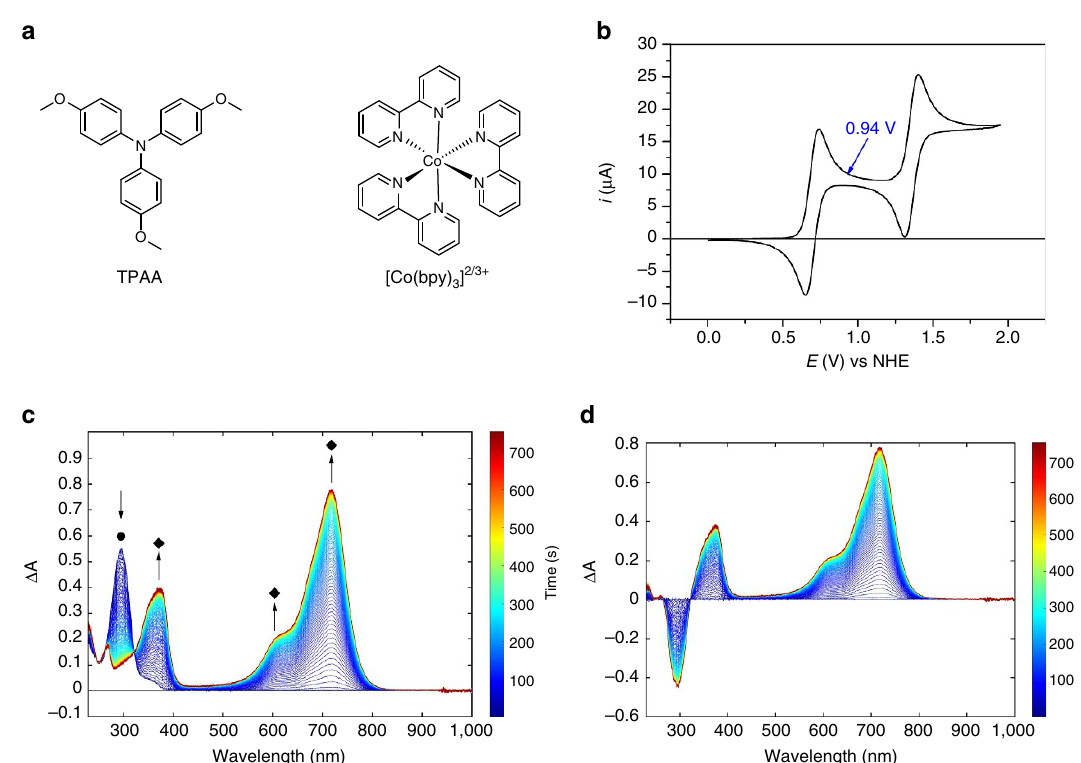
Figure 1 | Chemical compounds and electrochemistry. ( a ) Chemical structures of TPAA, [Co(bpy) 3 ](PF 6 ) 2 and[Co(bpy) 3 ](PF 6 ) 3 used in the present study. ( b ) Cyclic voltammogram of 1mM TPAA in 0.1M TBAPF 6 in ACN. The arrow indicates the position of applied potential in the spectroelectochemical measurements ( vide infra ); working electrode: platinum; counter electrode: graphite rod; reference electrode: Ag/AgNO 3 (10mM in ACN). Conversion to the NHE scale was conducted by calibrating the potential of the reference electrode with Fc/Fc þ redox couple (0.635V versus NHE) after the measurements ( c ) the evolution of the ultraviolet–visible spectra of TPAA after applying a fixed potential at 0.94V (versus NHE). Black circle for the absorption peak of TPAA; black diamond marks the absorption peak for TPAA ? þ . ( d ) The graph shows the difference of spectra.